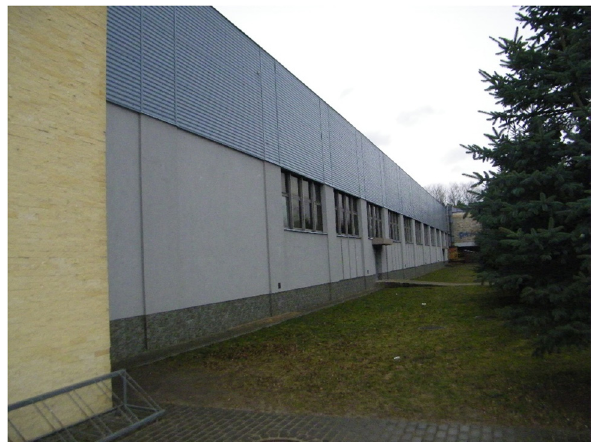
Figure 4: Municipal sports and recreation center in D ę bica ( source: Tomasz Sumera )